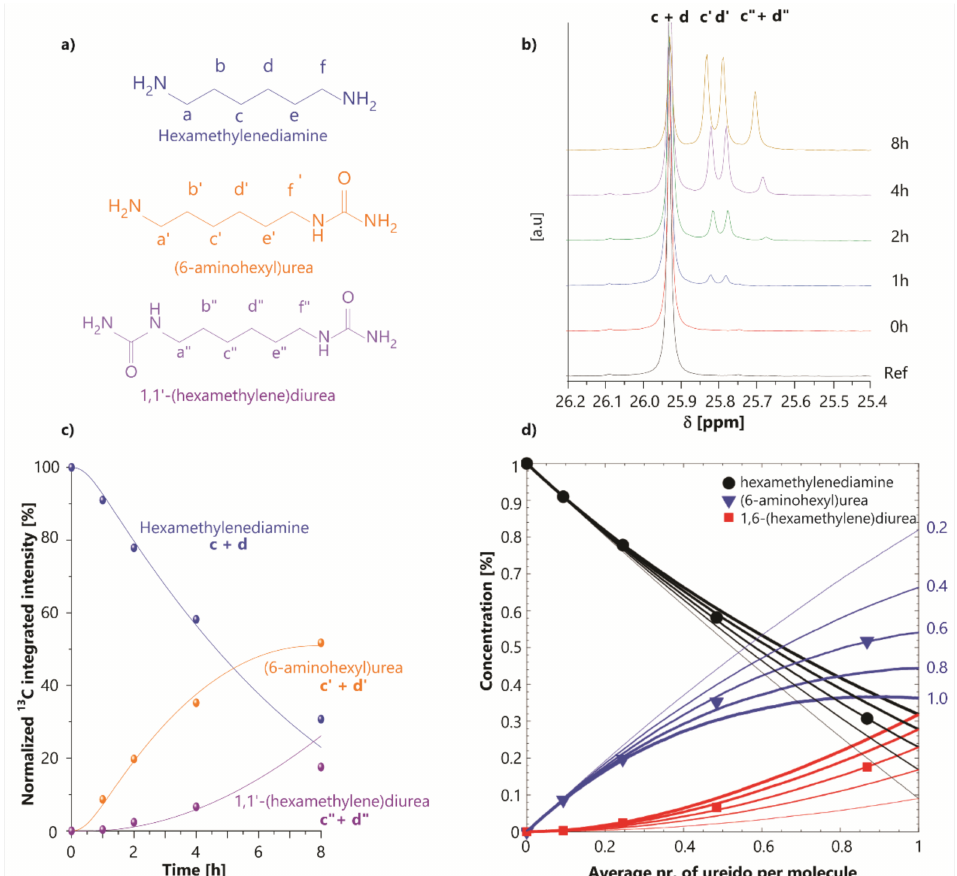
Figure 3. ( a ) Reactant and products of hexamethylenediamine/urea reaction. ( b ) 13 C NMR spectra: the spectra were aligned, and the c + d resonance is located at 25.9. ( c ) NMR integrals as a function of time: the fitted lines correspond to the results of the kinetic modeling (see Section 3.5). ( d ) Experimental (markers) and modeled (lines) concentrations of hexamethylenediamine: (6-aminohexyl)urea and 1,6-(hexamethylene)diurea as a function of reaction progress. The numbers on the right denote the probability ratio for Reaction B over Reaction A (Scheme 2) (see Figure 3d) (thickest line denotes equal